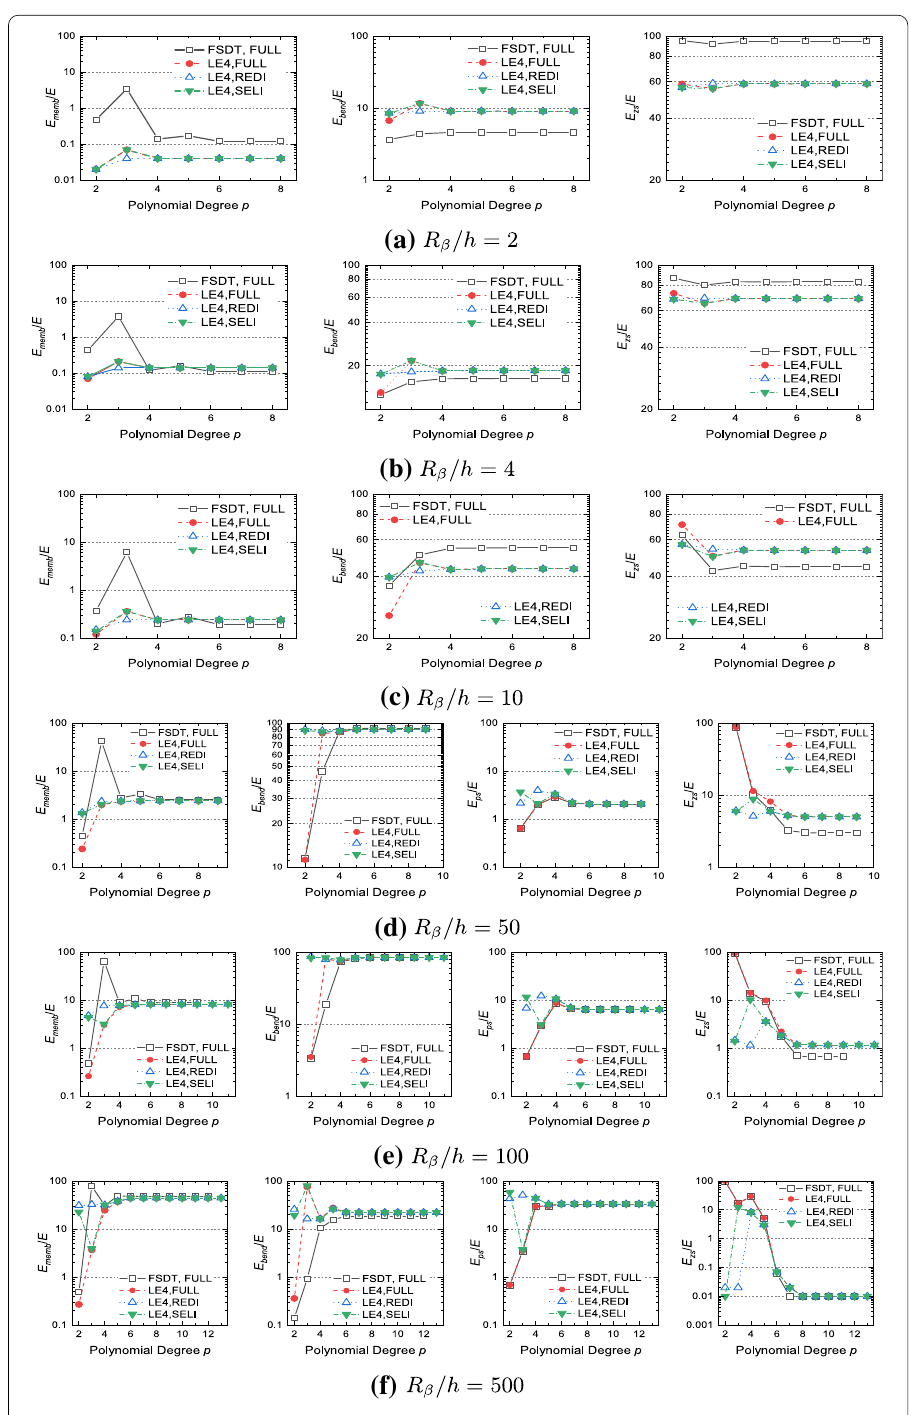
Fig. 10 Variation of strain energy components on the three-layered cylindrical shells under distributed pressure with respect to the element polynomial degree, for various radius-to-thickness ratio R β /